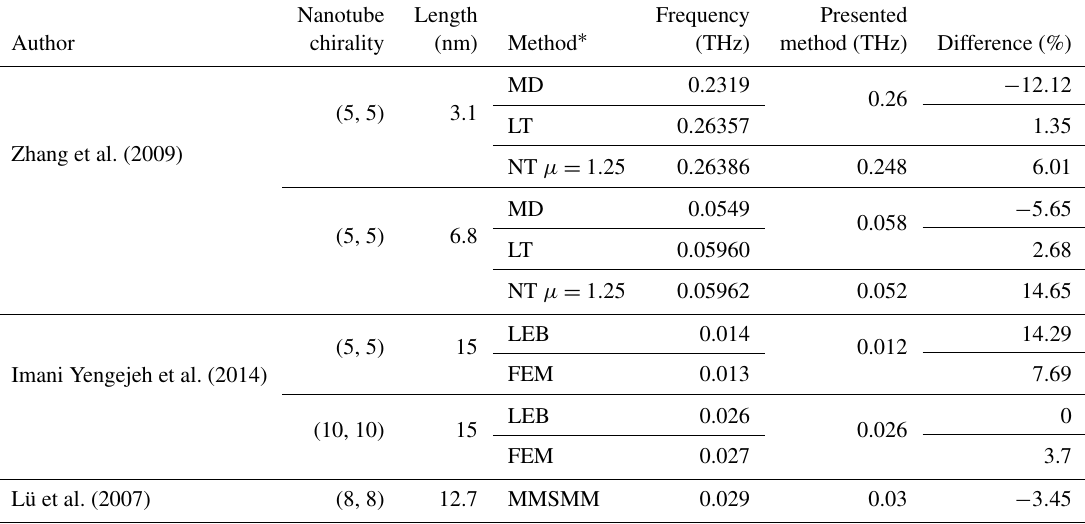
Figure 9. The first four eigenfrequencies of fixed–simply supported armchair nanotubes with nonlocal parameter µ = 0 . 4, (a) nanotube with chirality ( n , m ) = (10, 10) and diameter D = 1 . 356nm, (b) nanotube with and chirality ( n , m ) = (20, 20), diameter D = 2 . 712nm. Table 5. The comparison of the first eigenfrequencies with published results. Nanotube Length Frequency